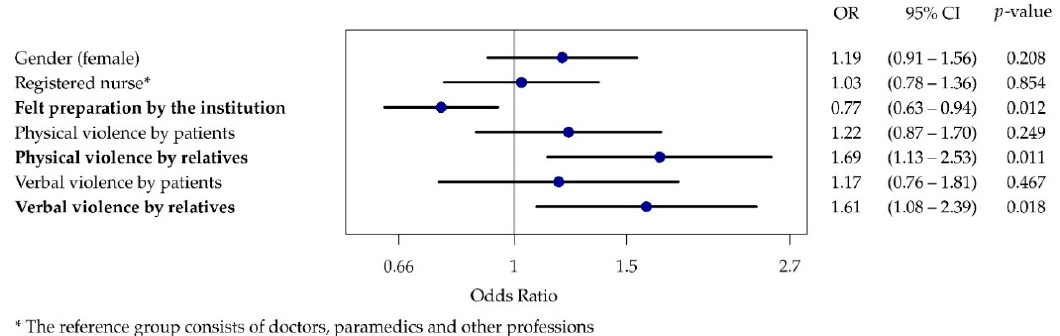
Figure 4. Forest plot of the ordinal regression results for high perceived stress due to violence experienced.